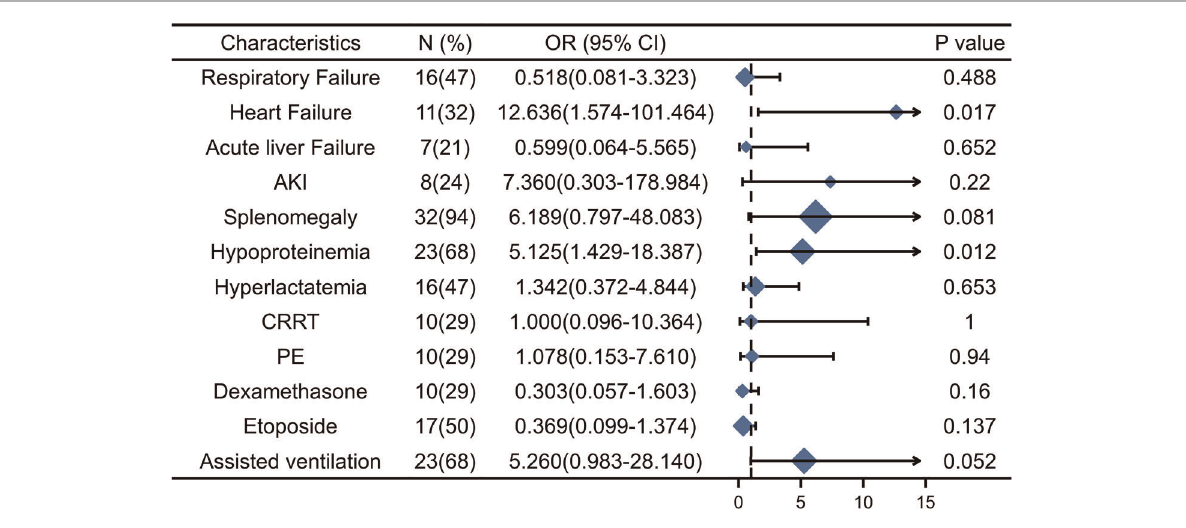
FIGURE 3 The subgroup analyses of overall survival. AKI, Acute kidney injury, CRRT, Continuous renal replacement therapy; PE, Plasma